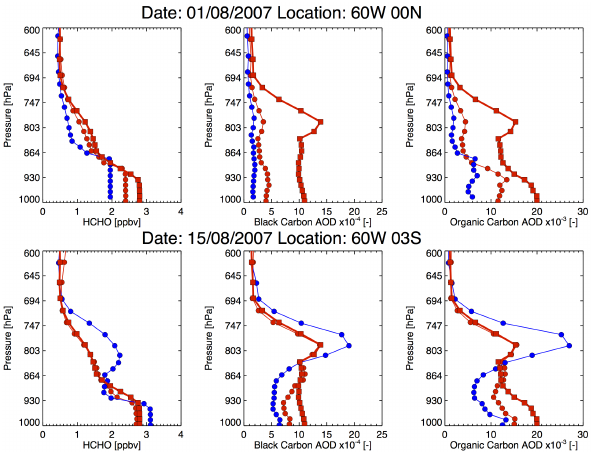
Figure 3. Vertical profiles of HCHO, black carbon and organic car- bon (AOD) simulated by GEOS-Chem at 4 ◦ × 5 ◦ (red solid circles), and 0.5 ◦ × 0.667 ◦ (blue solid circles) for two different locations and times. The red solid squares show the monthly mean 4 ◦ × 5 ◦ profile used in the AMF LUT approach discussed in Sect.